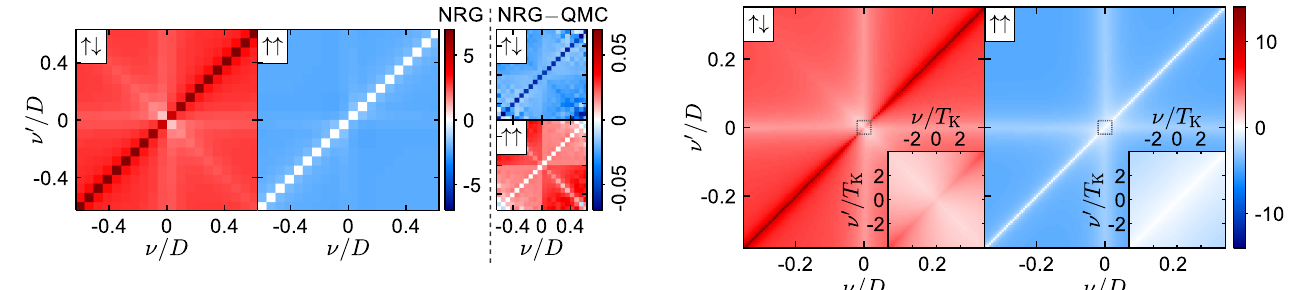
FIG. 7. MF 4p vertex F σσ 0 ð i ω Þ =U of the AIM as a function of ν and ν 0 at ω ¼ 0 and a moderately low temperature T ¼ 10 − 2 D . FIG. 8. F σσ 0 ð i ω Þ =U computed by NRG, analogous to Fig. 7, The labels ↑↑ and ↑↓ indicate the spin indices σσ 0 . The left-hand but at a much lower temperature, T ¼ 10 − 4 D . The inset enlarges panels show NRG results F NRG σσ ð i ω Þ =U . The right-hand panel the low-energy window marked by the small square. For 0 − F QMC =U , which ν ð0Þ ≲ T shows their difference to QMC data, ð F NRG σσ , the vertex is strongly suppressed, giving rise to the σσ 0 Þ 0 K is two orders of magnitude smaller than the original signal. Fermi-liquid regime of weakly interacting